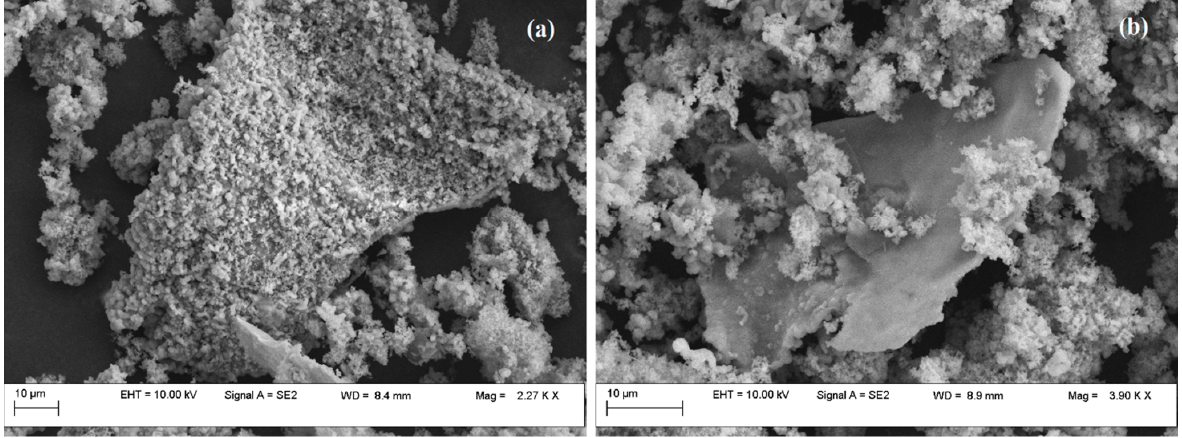
Figure 6. SEM images for Fe-MCM-41 r ( a ) and Ni-MCM-41 r ( b ).